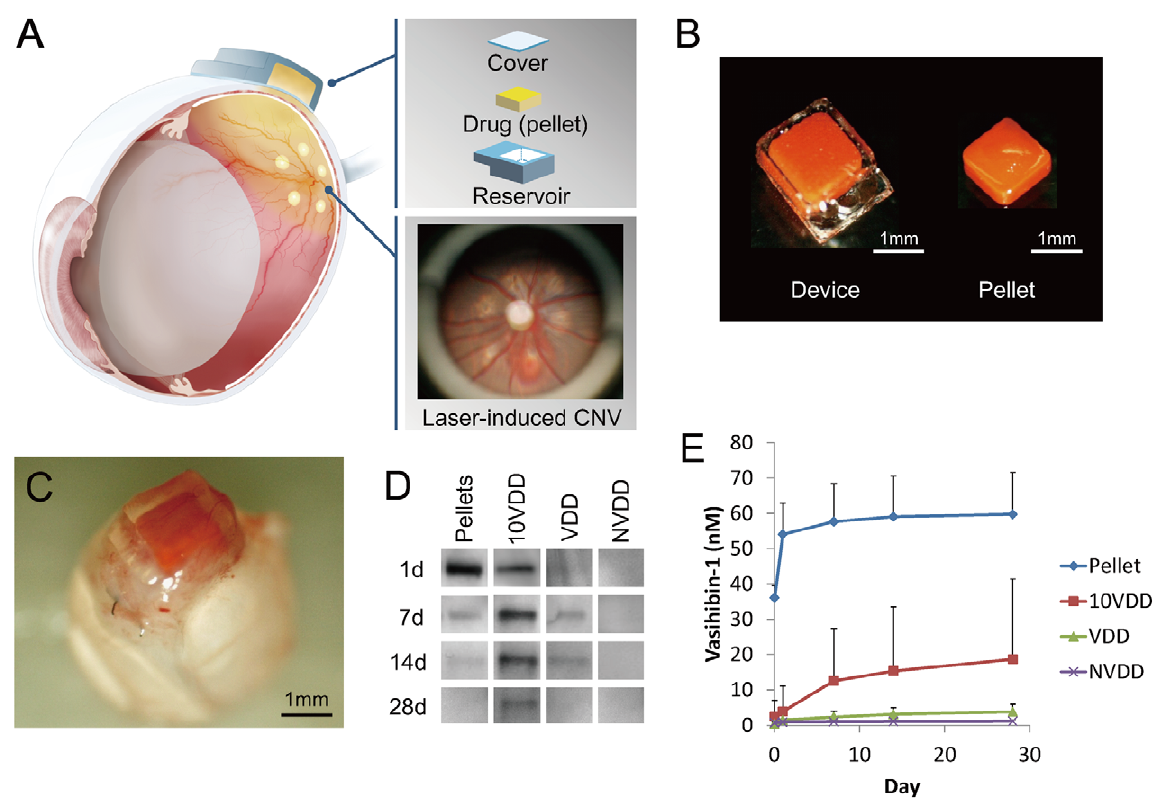
Figure 1. Device and vasohibin-1 release. (A) Schematic image of transscleral sustained vasohibin-1 delivery. We evaluated its effects via transscleral approach for rat laser-induced choroidal neovascularization (CNV). The device consists of a drug pelletized with PEGDM, a reservoir made of TEGDM, and a controlled-release membrane made of PEGDM that contains collagen microparticles. (B) Photograph showing a drug pellet and the delivery device containing a drug pellet. (C) Image of a device placed on the sclera of a rat eye at 3 days after implantation. The amount of vasohibin- 1 in the PBS was measured at 1, 7, 14, and 28 days after starting incubation. The representative results of western blotting and the result of ELISA are shown in (D) and (E), respectively. We collected the samples at only the given time points and replaced only the equal volume of PBS. The released vasohibin-1 amounts accumulated for 6, 7, and 14 days. [The pellet samples collected at Day 1 (shown as 1d) were diluted five times due to their concentration before they were evaluated by western blotting]. NVDD: non-vasohibin-1 (vehicle) delivery device, VDD: 1 m M vasohibin-1 delivery device, 10VDD: 10 m M vasohibin-1 delivery device, Pellets: vasohibin-1 pelletized at the same concentration of 10VDD (without reservoir and cover).